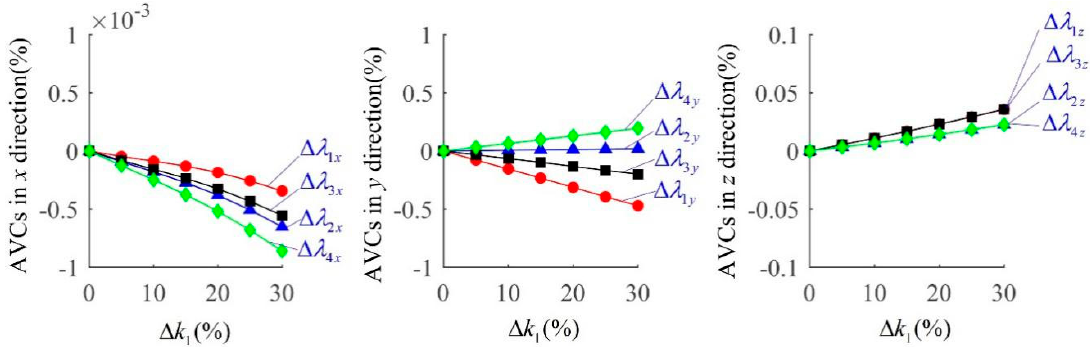
Figure 7. The amplitude variation coefficient curves of four elastic support points, including the amplitude variation coefficients in the x , y, and z directions.